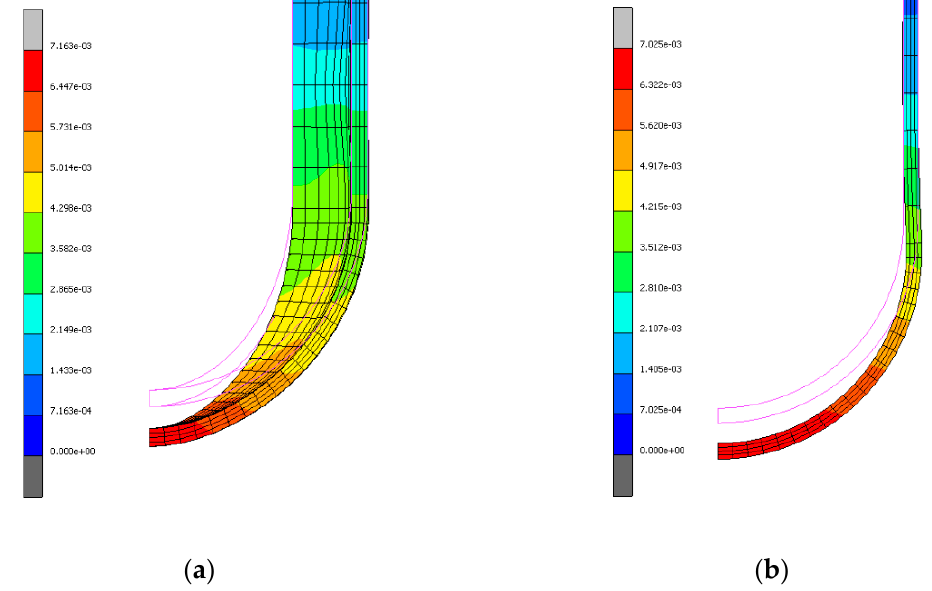
Figure 12. ( a , b ): 3D ( a ) and 2D ( b ) maximum displacement at the end of transient (28